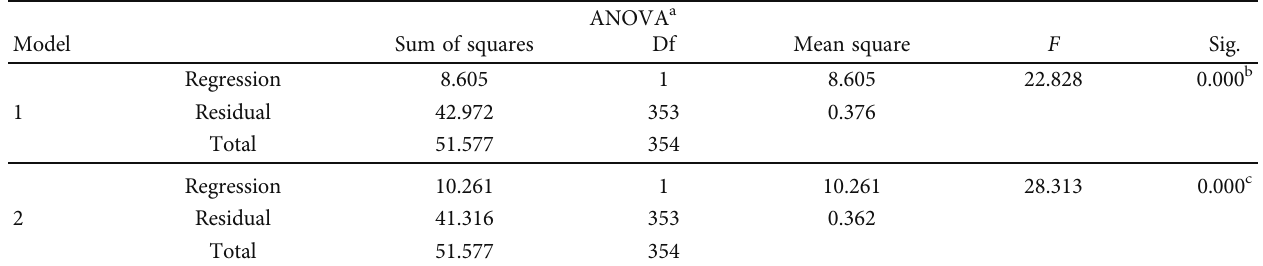
Table 10: Variation analysis of the variables (ANOVA).